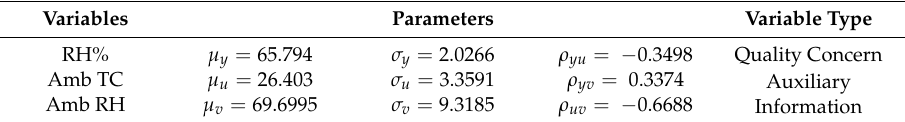
Table 5. Process parameters.